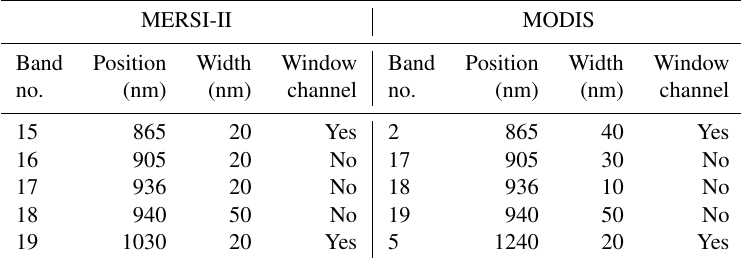
Table 1. Characteristics of NIR channels used in PWV retrievals of MERSI-II and MODIS. MERSI-II MODIS Band Position Width Window Band Position Width Window no. (nm) (nm) channel no. (nm) (nm) channel